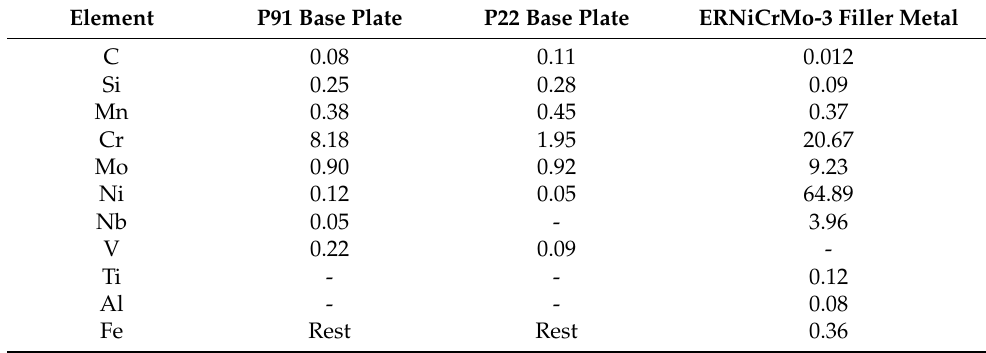
Table 1. Chemical composition of the P91 and P22 base plates and ERNiCrMo-3 filler metal (wt.